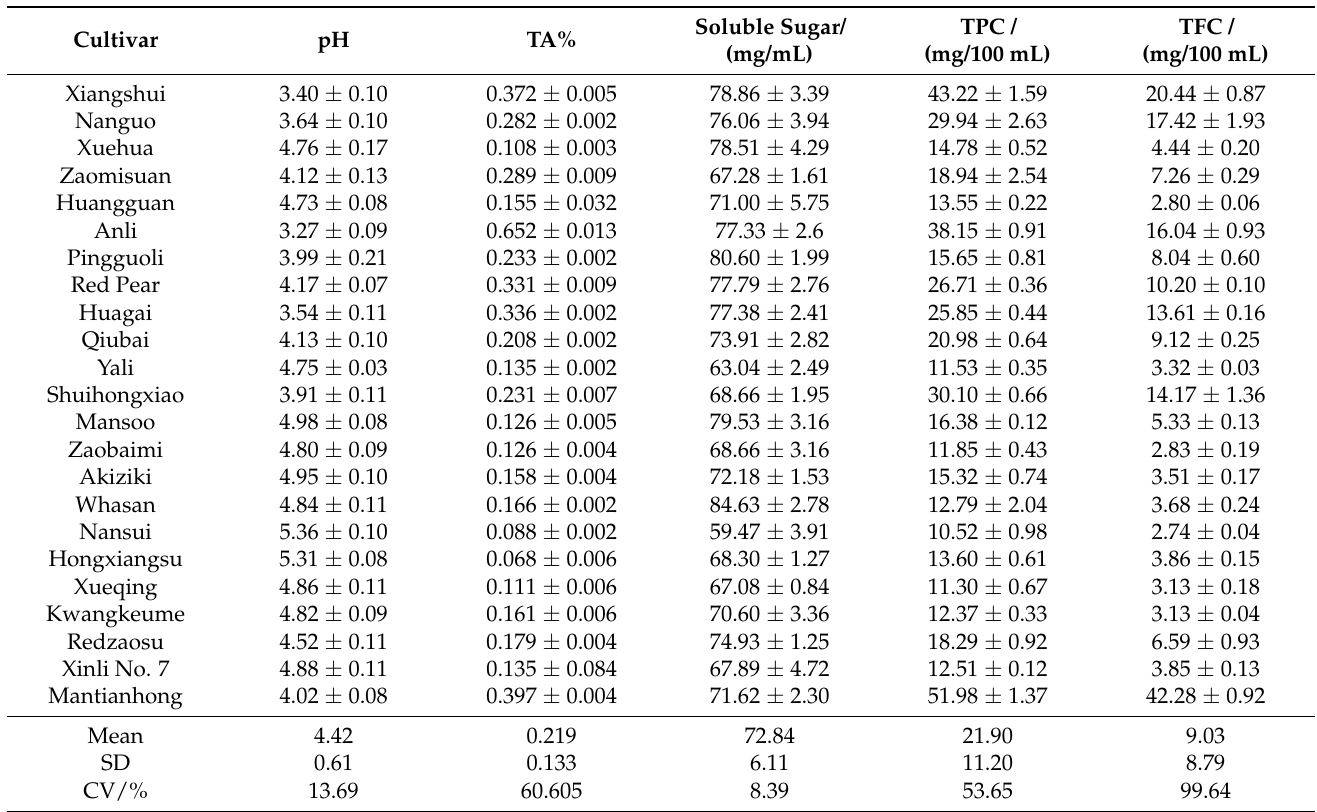
Table 3. Physicochemical properties of pear pastes from 23